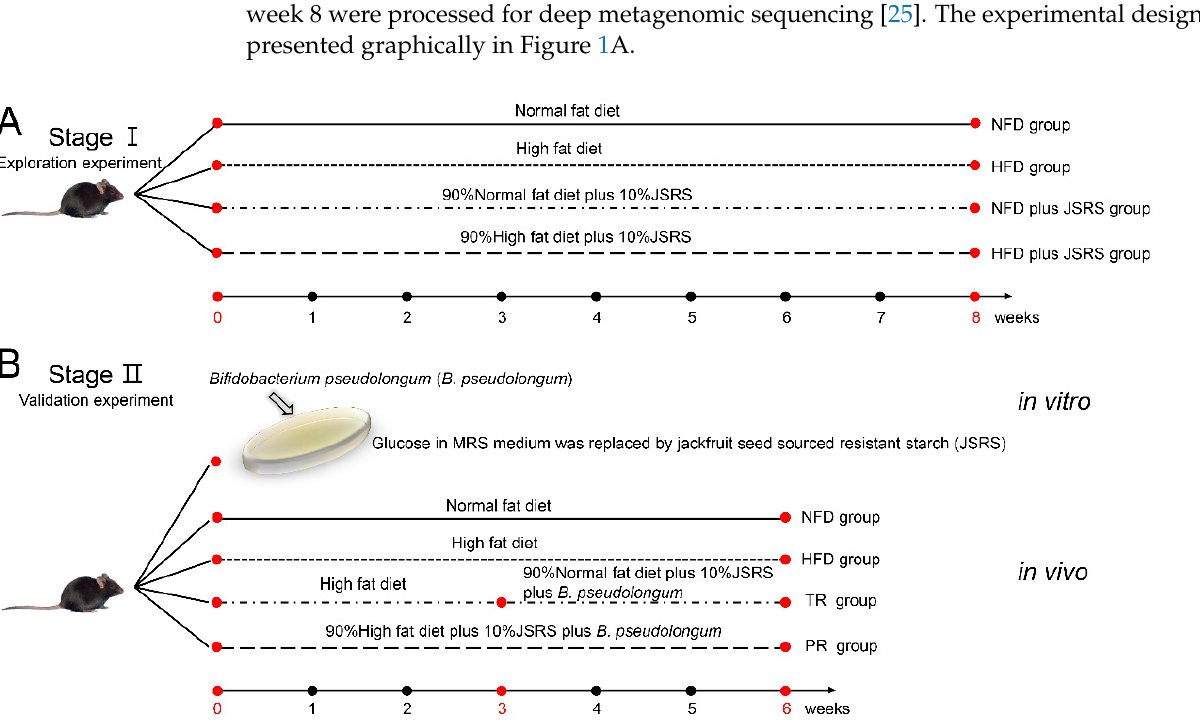
Figure 1. Experimental design. ( A ) In stage I, mice were randomly divided into four groups: NFD (normal-fat diet, n = 5); NFD plus JSRS (90% normal-fat diet plus 10% jackfruit seed sourced resistant starch, n = 6); HFD (high-fat diet, n = 6); HFD plus JSRS (90% high-fat diet plus 10% jackfruit seed sourced resistant starch, n = 6). The mice were kept for eight weeks. ( B ) The 4 groups that were treated for 3 weeks in order to make nutritionally obese mice model: NFD (normal-fat diet, n = 10); TR (HFD was chosen for the first 3 weeks for the development of obese mice model, then, 90% NFD plus 10% JSRSplus 8Log CFU B. pseudolongum infusions done later n = 10); HFD (high-fat diet, n = 10); PR (90% HFD plus 10% JSRS plus 8Log B. pseudolongum infusions, n = 10). After 3 weeks, three mice in each group were euthanized to observe abdominal fat accumulation. Then a 3-week intervention was continued on respective dietary treatments until the end of the